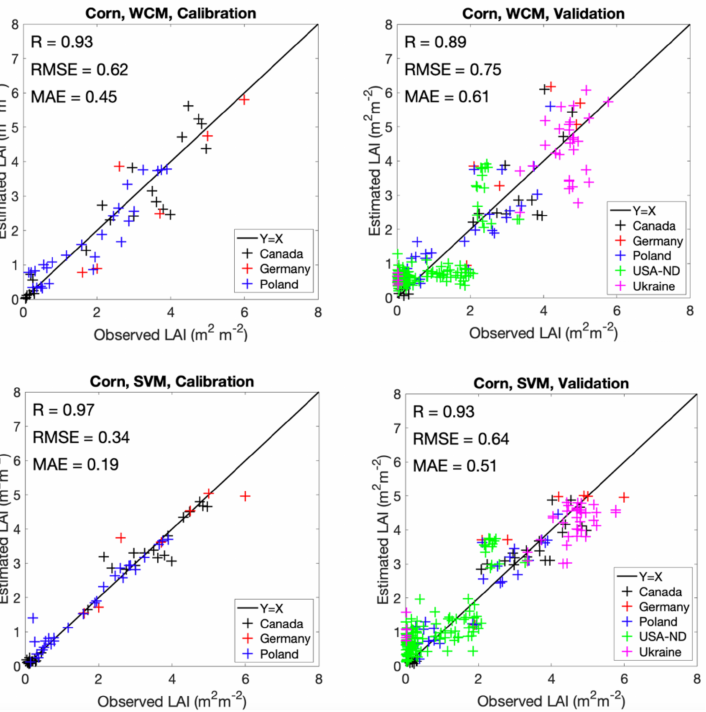
Figure 3. The calibration and validation results for corn for five JECAM sites (Canada, Germany, Poland, USA-ND, and Ukraine).